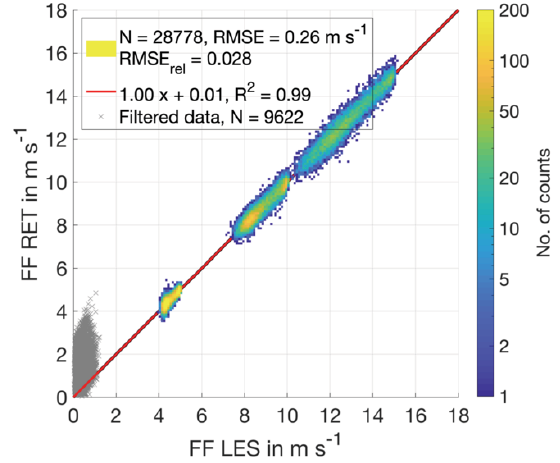
Figure 2: LES input wind speed (FF LES) and ADL retrieved wind speed (FF RET) for an ideal measurement system with specifications according to Tab.